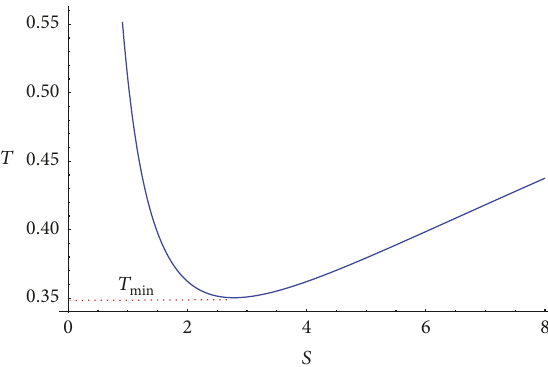
Figure 3: The figure shows 𝑇 versus 𝑆 for 𝛾 = 1 . Here 𝜆 = 2.4 , Λ = −3 , and 𝑄 = 0.3 .